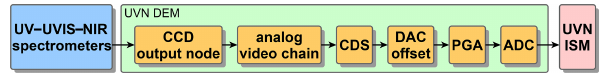
Figure 2. Schematic of the read-out chain of the UVN detectors. In the output node charge is converted to a voltage, the analog video chain amplifies the signal with a fixed gain, the signal is detected in the correlated double sampling unit (CDS), an analog offset can